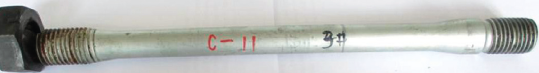
Figure 1: Macromorphology of fractured bolt.